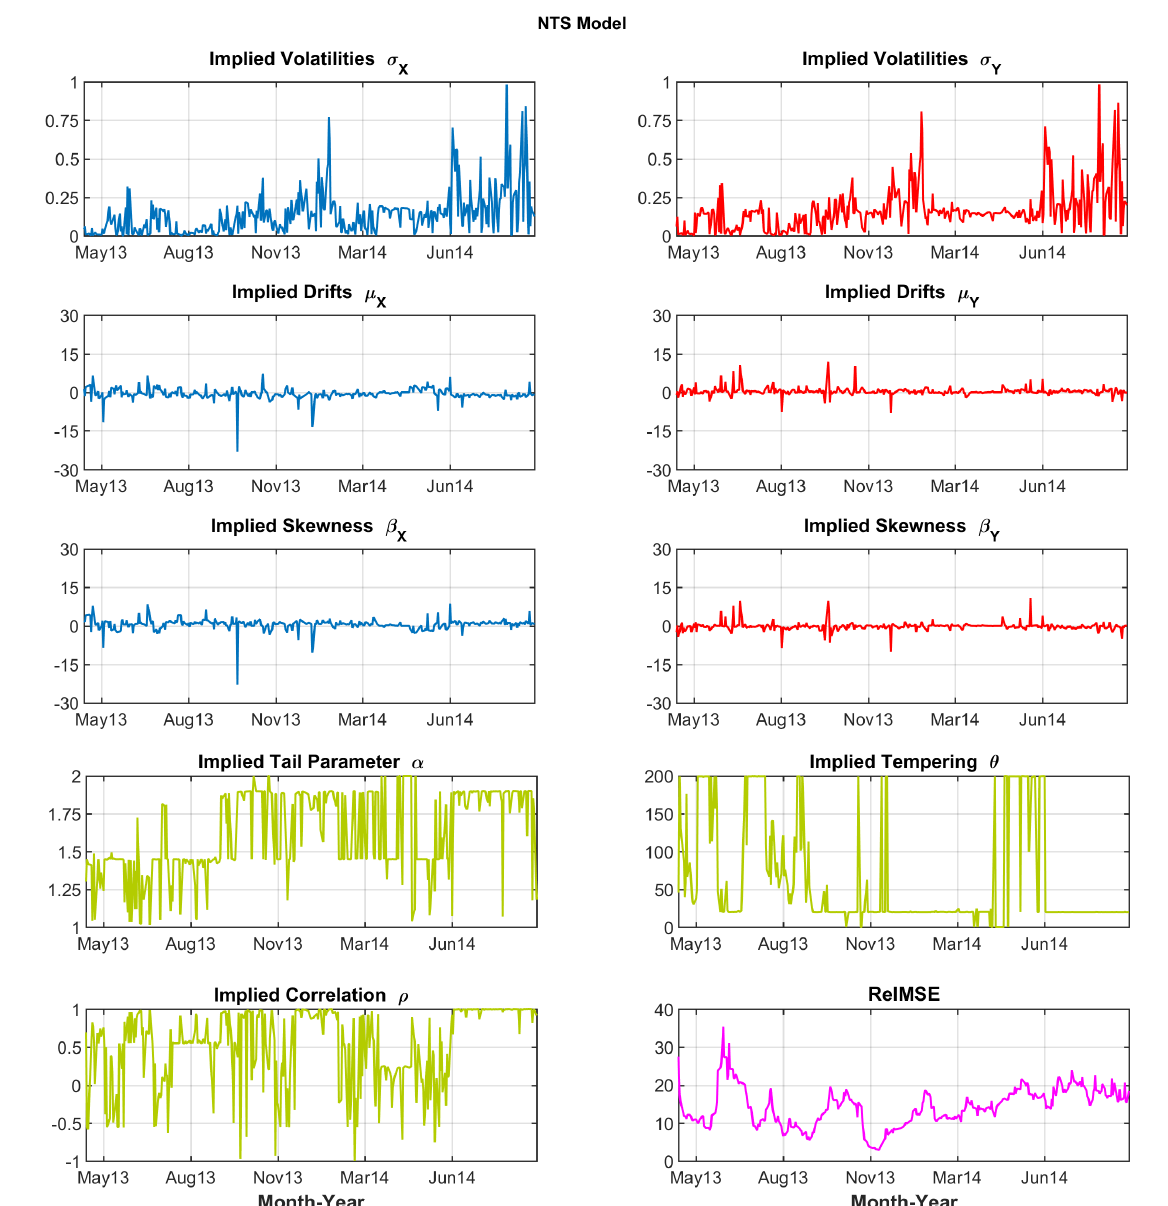
Figure 6. Quanto Calls: daily calibrated implied ( X , Y ) NTS parameters and RelMSE. Sample period 16 April 2013 to 15 September